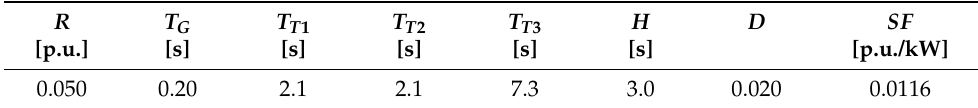
Figure 3. Power system model with synthetic inertia contribution. Table 1. Power system model